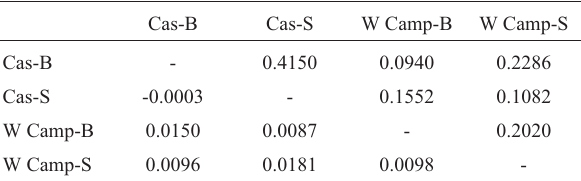
Table 5 - Population pairwise (cid:3) ST values among samples obtained from MBU and STD strategies. Population codes are reported as in Table 2. Conventional (cid:3) ST values are shown below the diagonal and corresponding P values with significance level (cid:4) 0.05 are shown above the diagonal.